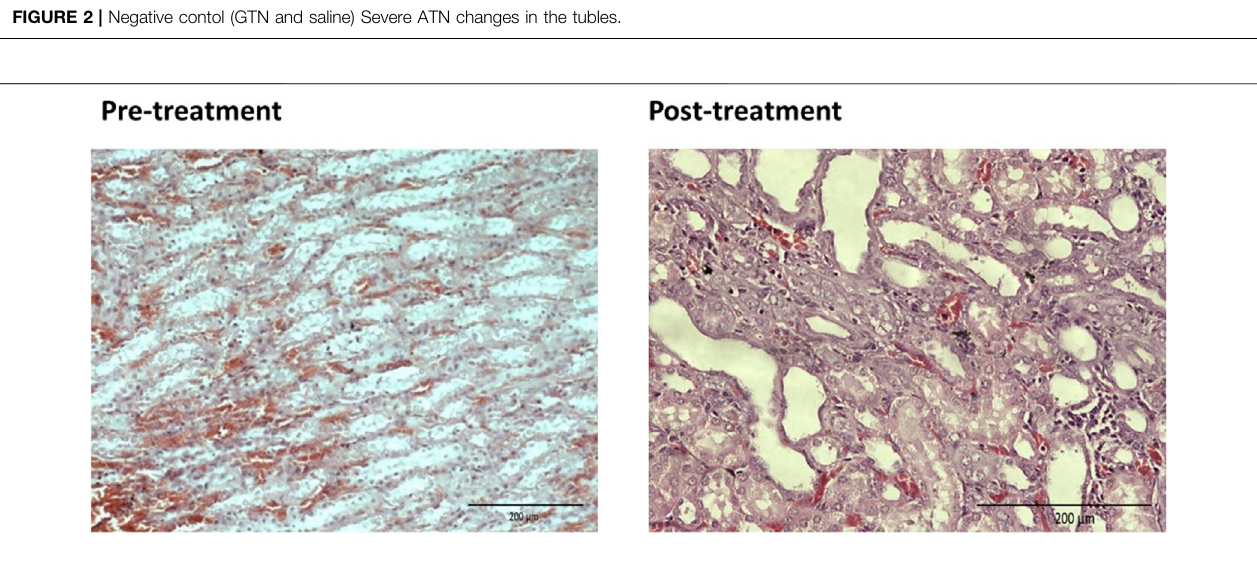
FIGURE 3 | Postive control (GTN and NAC) Severe ATN changes.